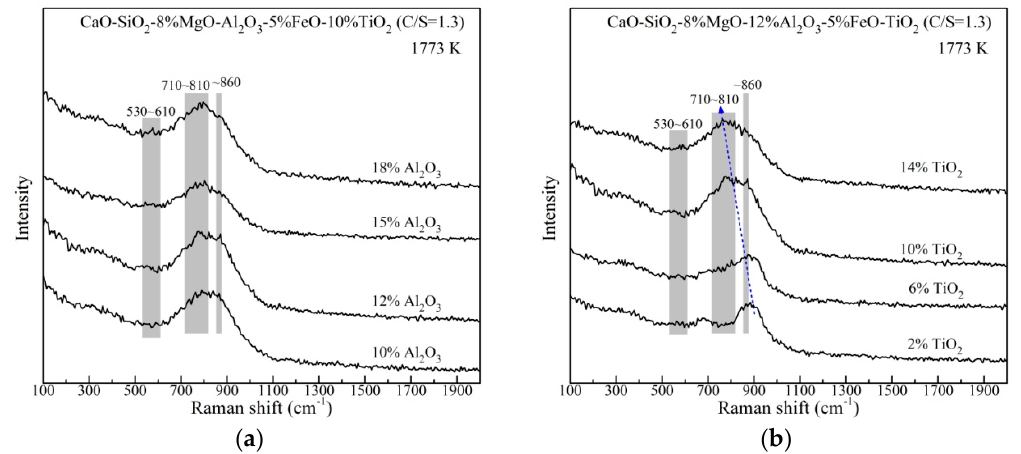
Figure 8. Original Raman spectroscopy of the rapidly quenched slags with different ( a ) Al 2 O 3 content and ( b ) TiO 2 content.